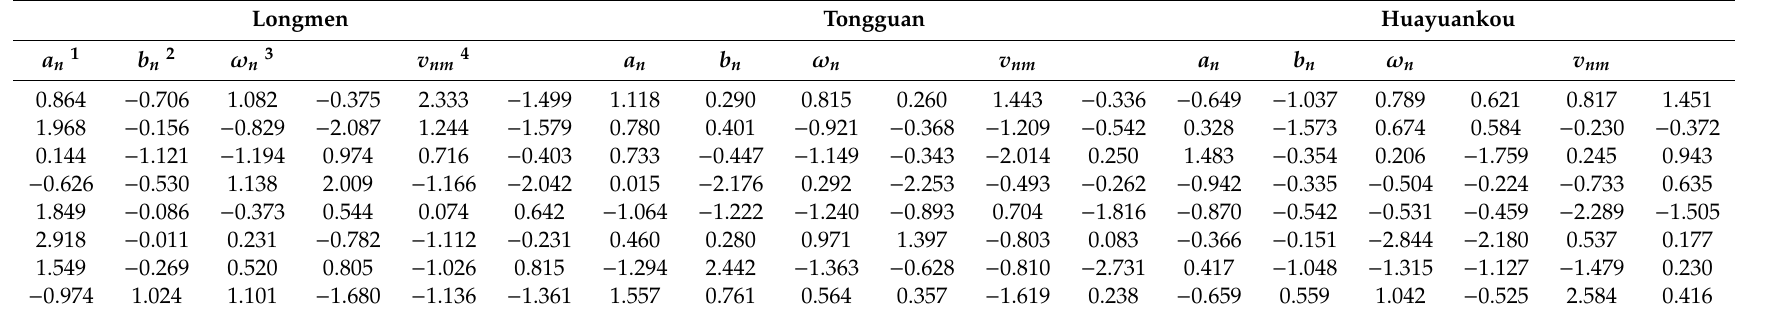
Table 8. Related parameters of SL − runo ff − SSC cointegration equation.